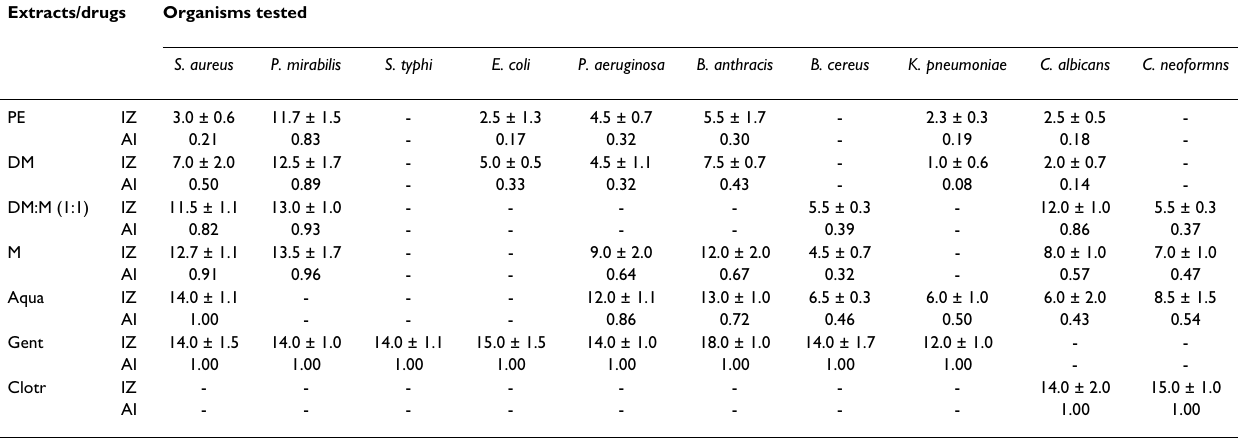
Table 3: Antimicrobial activity of T. brownii root extracts Extracts/drugs Organisms tested